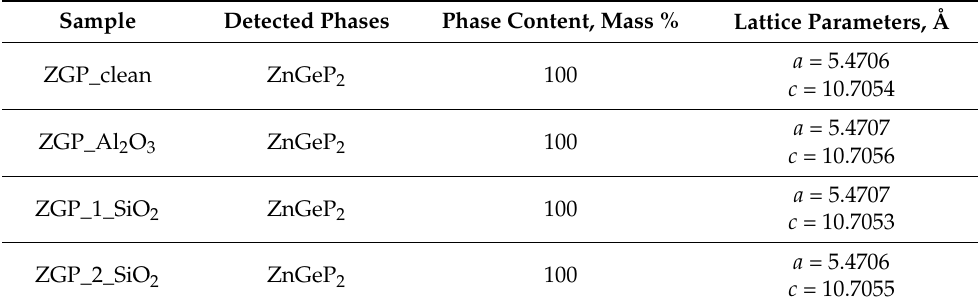
Table 1. Results of X-ray diffraction analysis of the samples under